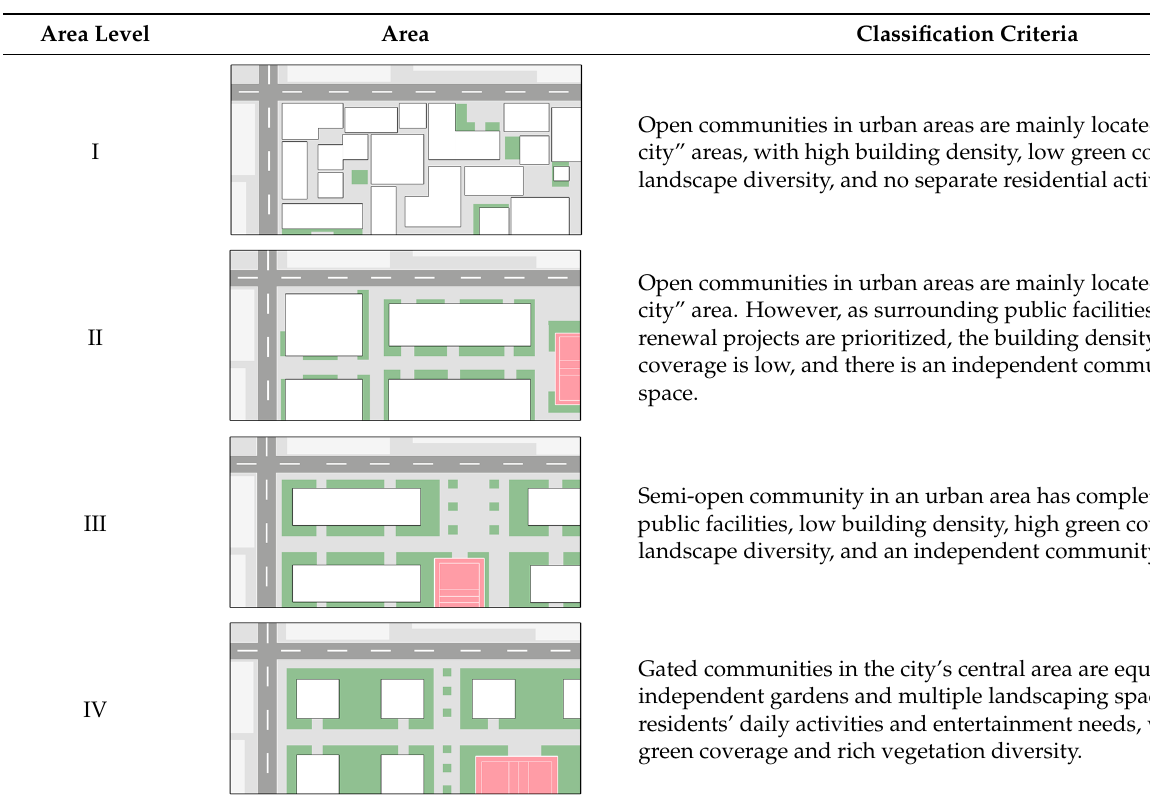
Figure 2. Comparison of the 2 ‐ D, 2.5 ‐ D, and 3 ‐ D observation areas. Table 1. Conceptual classification of four typical communities in China based on spatial features.